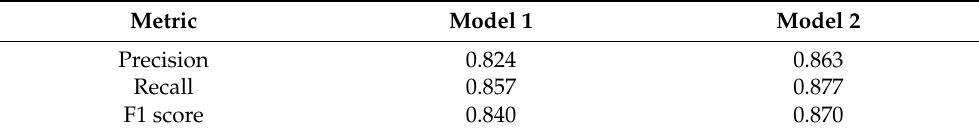
Table 3. Precision, recall and F1